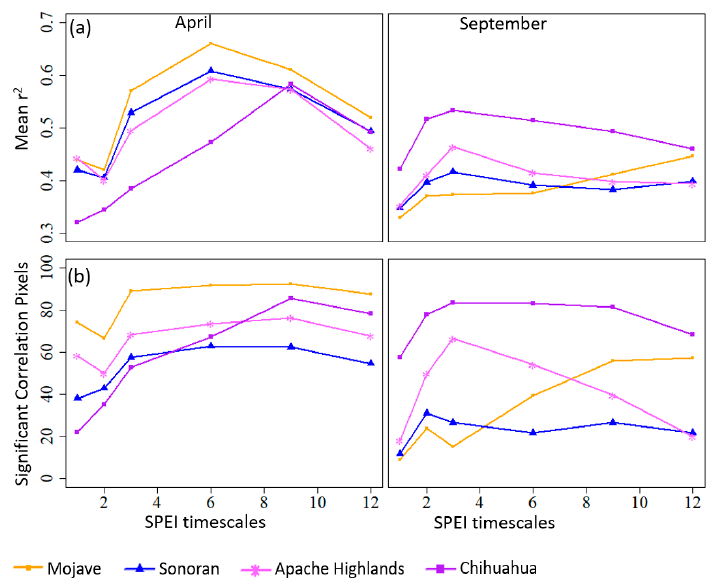
Figure 8. The spatial mean r 2 ( a : top) and percentage of the significantly correlated pixel ( b : bottom) computed from the correlation matrices of NDVI and different SPEI timescales of four ecoregions that are significant at p ≤ 0.05 for April (winter: left) and September (summer: right).